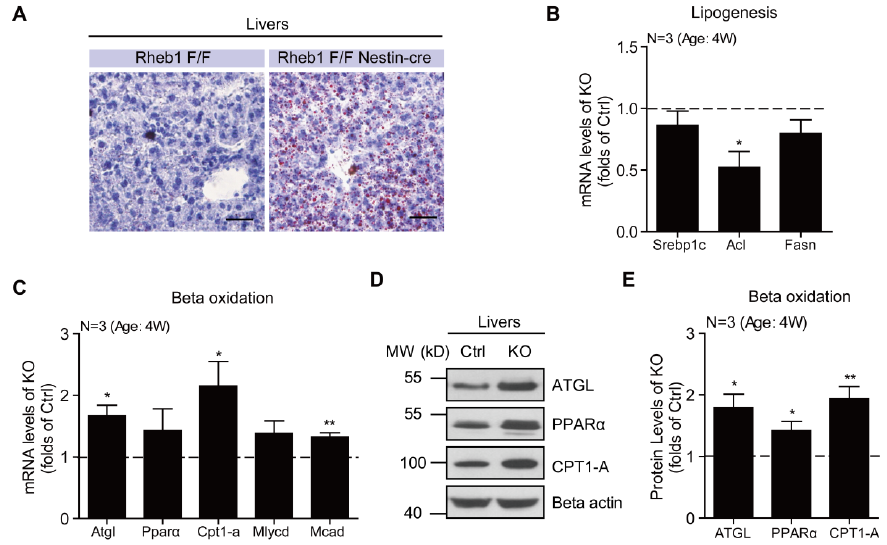
Figure 4. Genetic deletion of Rheb1 in the brain increases liver lipid droplets and beta oxidation. ( A ) Representative oil red O staining images showing increased number of lipid droplets in livers of Rheb1 ko mice. Bar 25 μ m; ( B ) Real-time PCR assays showing that hepatic lipogenesis genes Srebp1c , Acl and Fasn are not increased in livers of Rheb1 ko mice ( N = 3). Results are averages of three independent animals. Data represent mean ± SEM. * p < 0.05; ( C ) Real-time PCR assays showing the increasing of mRNA levels of beta-oxidation genes, Atgl , Ppar α , Cpt1-a , Mlycd and Mcad in livers of Rheb1 ko mice ( N = 3). Results are averages of three independent animals. Data represent mean ± SEM. * p < 0.05, ** p < 0.01; ( D , E ) Western blots and histograms showing the increasing of protein levels of ATGL , PPAR α and CPT1-A in livers of Rheb1 ko mice ( N = 3). Results are averages of three independent animals. Data represent mean ± SEM. * p < 0.05, ** p <